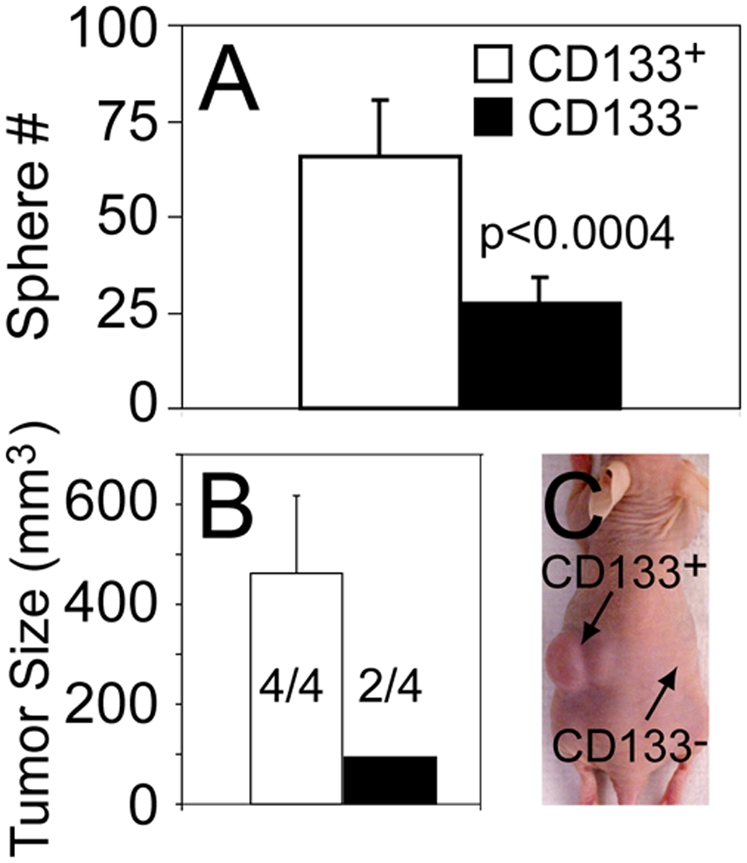
CD133 expressing neuroblastoma cells show increased sphere and tumor formation.Cells sorted for CD133 expression were assayed for (A) tumorsphere formation and (B) tumorigenicity following flank implantation of 5,000 cells in immunodeficient mice. Quantification of tumor volume and frequency were performed at 21 days post-inoculation. Numerators indicate number of flanks with tumors and denominators total number of flanks injected. (C) Image of mouse injected with CD133 expressing cells on the left flank and CD133 null cells on the right flank.